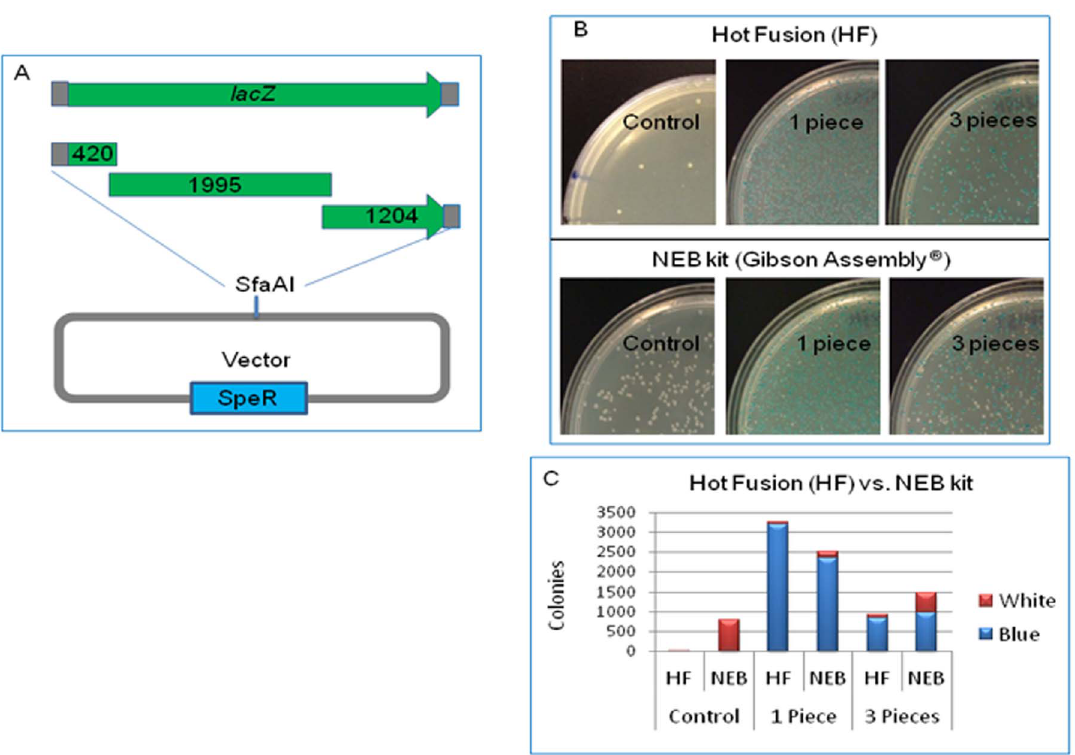
Fig. 8. Comparison study of Hot Fusion and Gibson Assembly (NEB kit). (A) Cloning strategy for single and multi-fragment assembly. A full lacZ gene and three pieces of the lacZ gene with overlapping sequences were amplified, and cloned into a base vector digested with SfaAI (unpurified). (B) Transformation efficiency of lacZ assembly by Hot Fusion and Gibson Assembly (from NEB). The top panels are the transformation plates from Hot Fusion. The bottom panels are the transformation plates from Gibson Assembly. The same amount of base vector was used in all reactions and the same amount of insert was used in the same treatment. Blue colonies contain the lacZ gene or all three pieces of the lacZ gene correctly cloned or assembled together (in frame). White colonies contain the parent vector. (C) Cloning efficiency of Hot Fusion and Gibson Assembly. Colonies were counted from each transformation